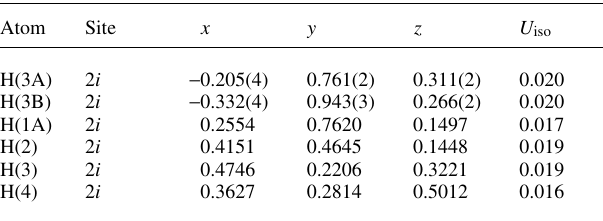
Table 2. Atomic coordinates and displacement parameters (in Å 2 )